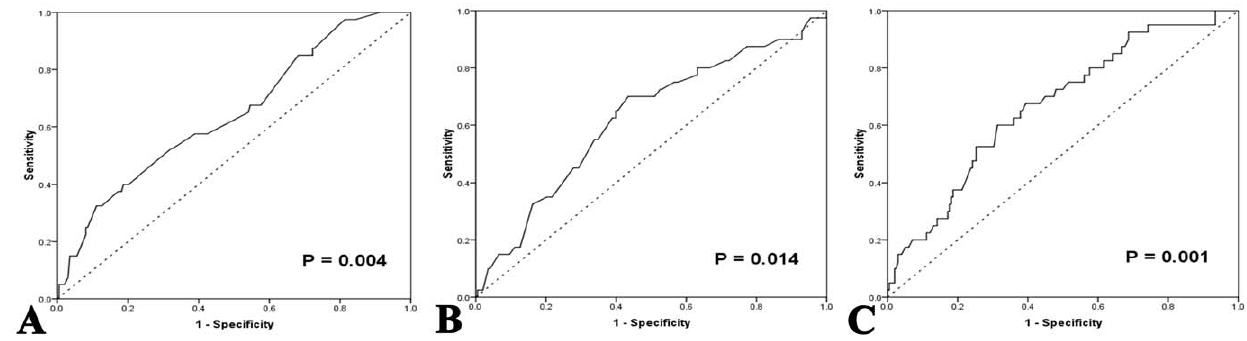
Figure 1. ROC curves analysis for AMC, ALC, and LMR at diagnosis in the training set. A: ROC curves analysis for AMC at diagnosis in the training set. B: ROC curves analysis for ALC at diagnosis in the training set. C: ROC curves analysis for LMR at diagnosis in the training set. ROC, receiver operating characteristic; AMC, absolute monocyte count; ALC, absolute lymphocyte count; LMR, lymphocyte-to-monocyte ratio.